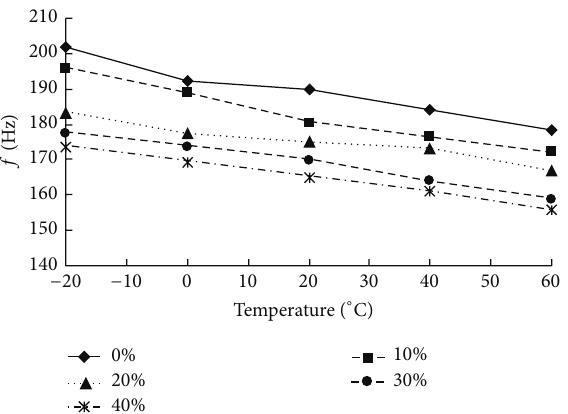
Figure 13: Integrated effect of temperature and damage on the first order natural frequency.